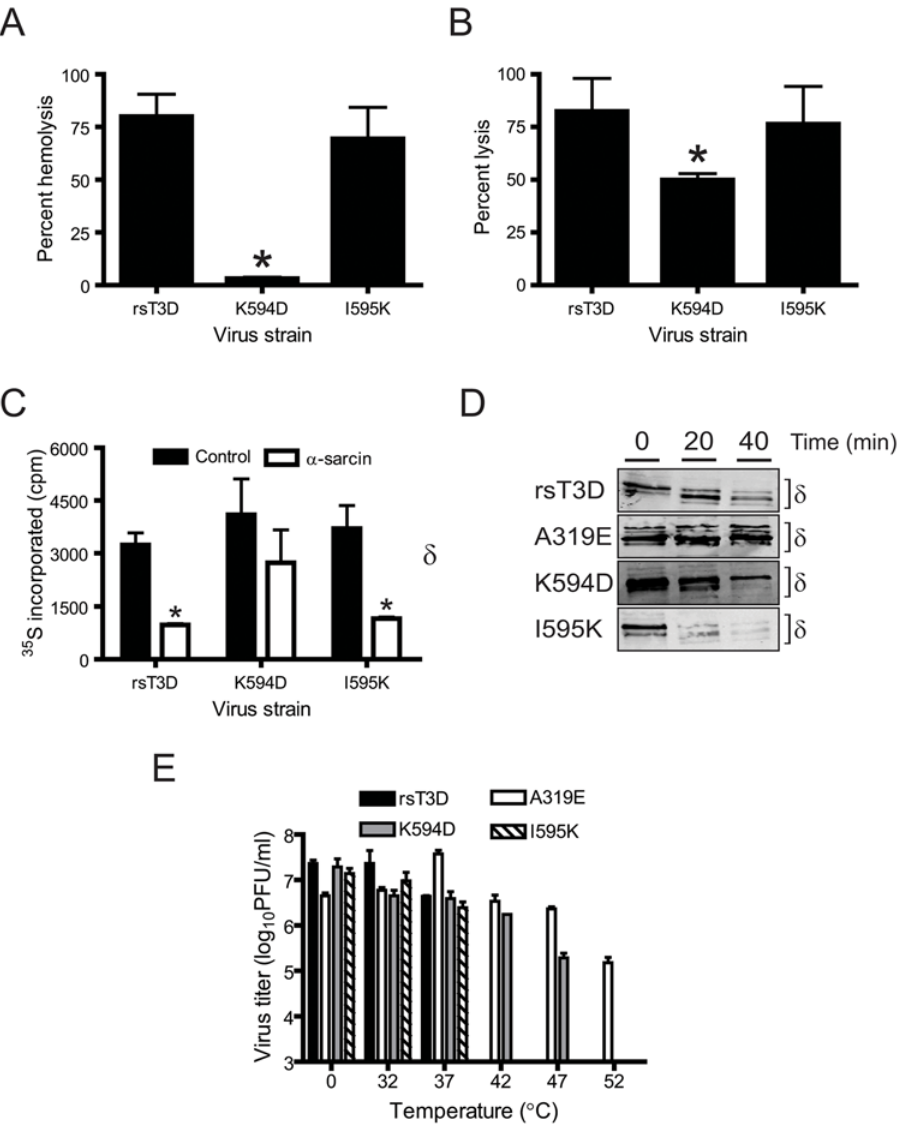
Figure 3. K594D exhibits altered capacity for membrane penetration. (A) A 3% v/v solution of bovine erythrocytes was incubated with 5.4 6 10 10 ISVPs of rsT3D or the indicated Q mutant at 37 u C for 1 h. Hemolysis was quantified by determining absorbance of the supernatant at 415 nm. Hemolysis following treatment of an equal number of cells with virion-storage buffer or virion-storage buffer containing 1% TX-100 was considered to be 0 or 100%, respectively. Results are expressed as mean percent hemolysis for triplicate samples. Error bars indicate SD. *, P , 0.05 as determined by Student’s t -test in comparison to rsT3D. (B) L929 cells preincubated with 51 Cr-labeled sodium chromate were adsorbed with 10 5 ISVPs/ cell of rsT3D or the indicated Q mutant at 4 u C for 1 h and incubated at 37 u C for 4 h following addition of complete medium. The amount of 51 Cr released into the medium was determined by liquid scintillation. 51 Cr release following treatment of an equal number of cells with virion-storage buffer or by addition of 4% TX-100 to the medium was considered to be 0 or 100%, respectively. Results are expressed as mean percent lysis for triplicate samples. Error bars indicate SD. *, P , 0.05 as determined by Student’s t -test in comparison to rsT3D. (C) HeLa cells starved of cysteine and methionine were adsorbed with 10 6 ISVPs/cell of rsT3D or the indicated Q mutant at 4 u C for 1 h. Infection was initiated in medium containing 35 S- labeled cysteine and methionine in the presence or absence of a -sarcin. Cells were lysed following incubation at 37 u C for 1 h. Proteins were precipitated with TCA, and acid-precipitable radioactivity was quantified by scintillation counting. Results are expressed as mean 35 S incorporated for triplicate samples. Error bars indicate SD. *, P , 0.05 as determined by Student’s t -test in comparison to 35 S incorporated in the absence of a -sarcin. (D) CsCl-treated ISVPs of rsT3D or the indicated m 1 mutant were incubated with trypsin at 4 u C for the intervals shown. Samples were resolved by SDS- PAGE and immunoblotted using a MAb specific for m 1. The position of the d band is shown. (E) ISVPs of rsT3D or the indicated m 1 mutant were incubated at the temperatures shown for 15 min. Residual infectivity was assessed by plaque assay. Results are expressed as mean residual titer for triplicate samples. Error bars indicate SD.